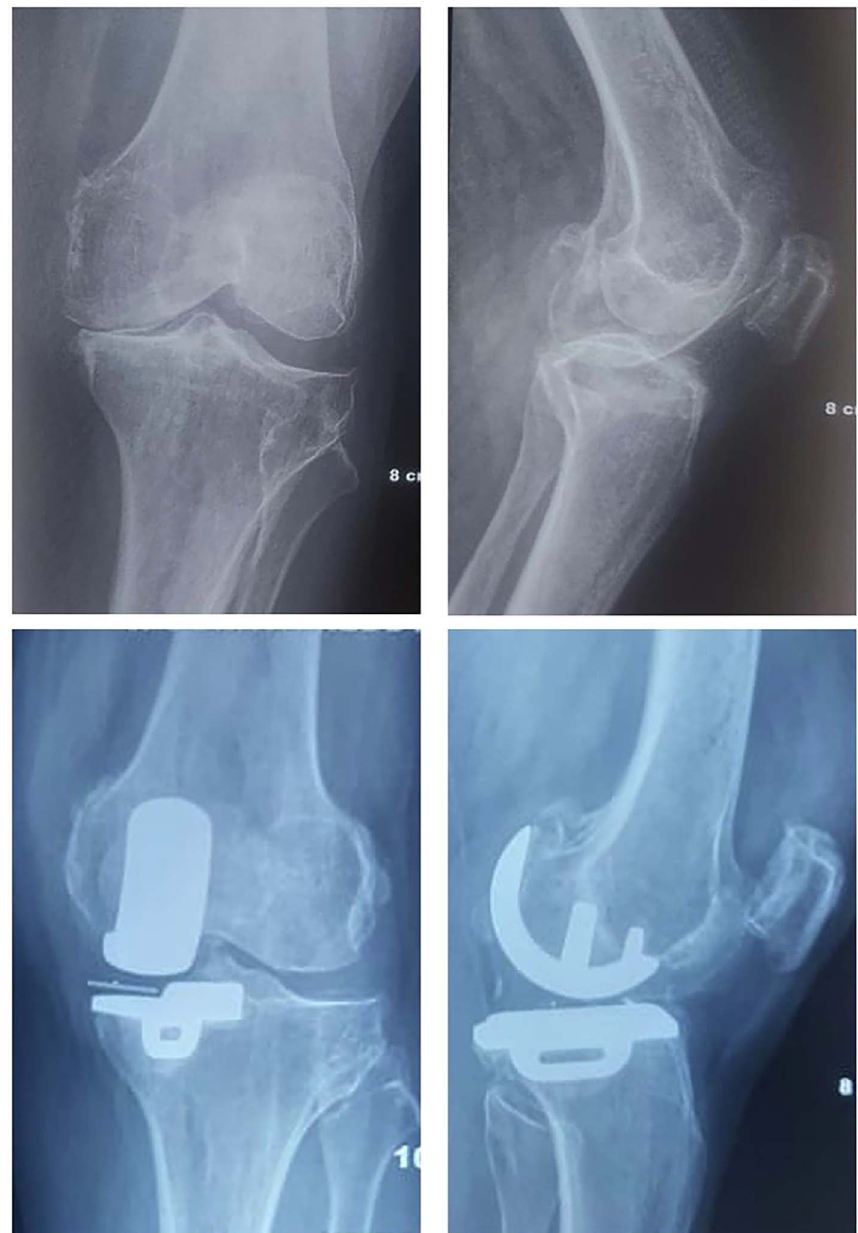
Figure 2. Pre- and Post-operative radiographs of Oxford mobile bearing UKA for medial OA of the